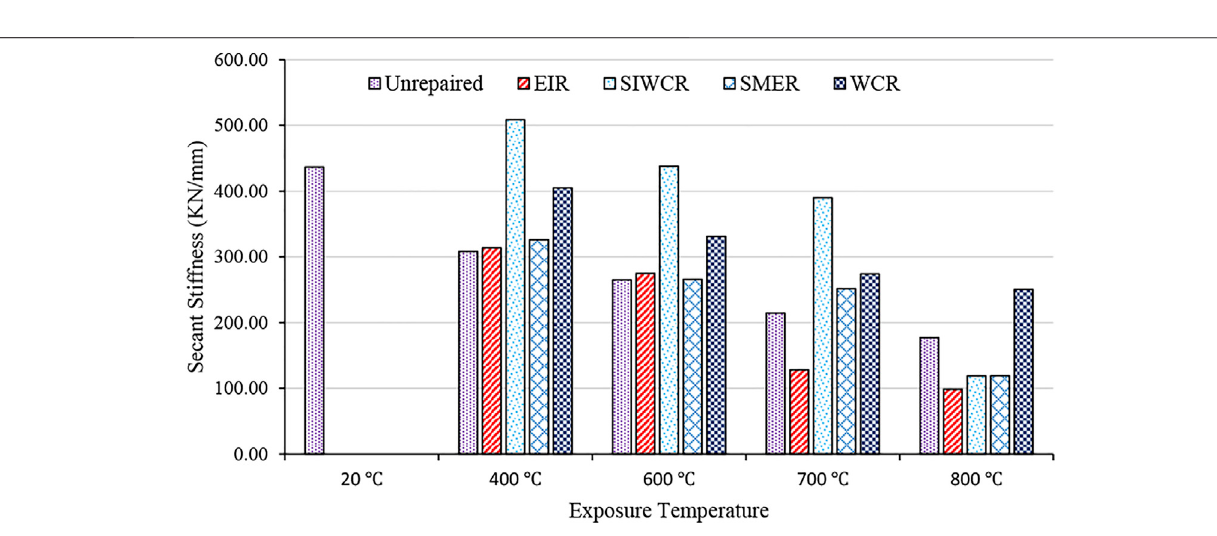
FIGURE 12 | Comparison of Secant Stiffness for various repair techniques and temperature